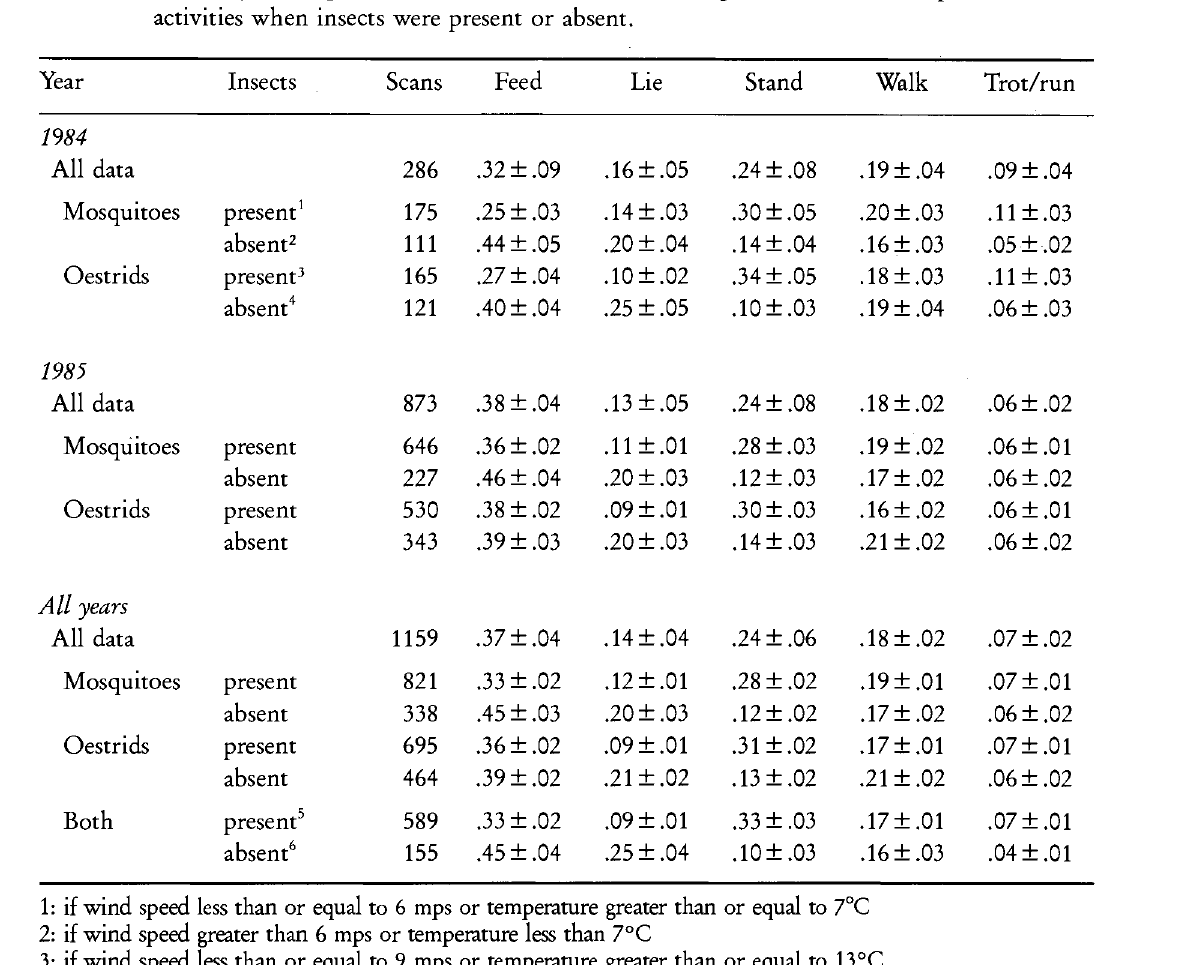
Table 4.5. Summary of proportion of time in summer the Porcupine Caribou Herd spent in various activities when insects were present or